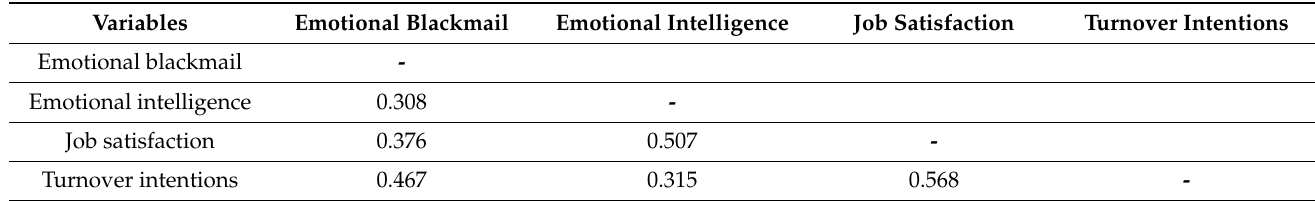
Table 4. Discriminant Validity: Heterotrait-monotrait (HTMT)